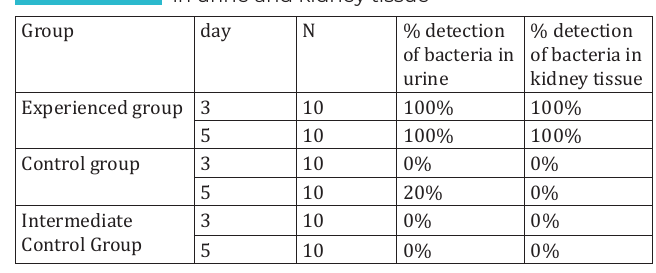
Indicators of positive detection of E.coli